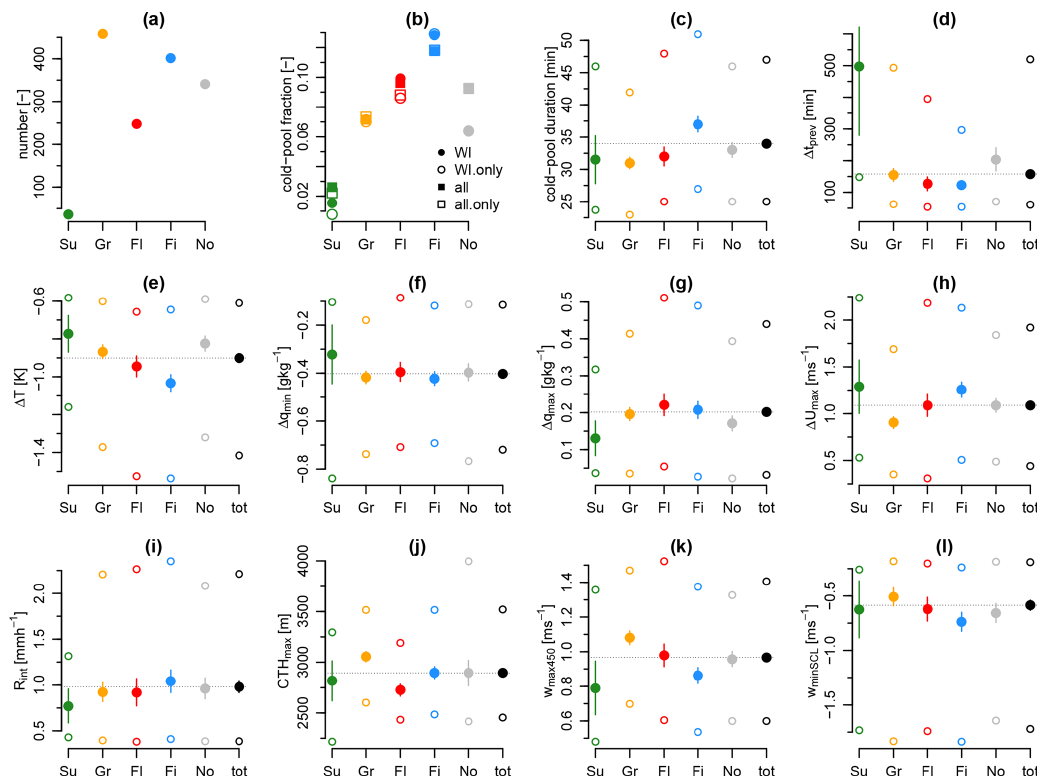
Figure 7. Distributions of various cold-pool diagnostics conditioned on the organization patterns. (a) Number of cold pools, (b) cold-pool fraction, (c) cold-pool duration, (d) time since t min of the last cold pool, (e) (cid:49)T , (f) (cid:49)q min , (g) (cid:49)q max , (h) (cid:49)U max , (i) MRR R int , (j) CTH max , (k) w max450 , and (l) w minSCL . The different symbols in panels (c) – (l) represent the 25%, 50%, and 75% quartiles of the respective variables, the solid lines represent the median ± 1SE, and the dotted horizontal reference lines show the median of the entire set (“tot”). Besides the cold pools matching the noprevWI criterion, panel (b) also shows the fraction of cold pools for all seasons (“all”) and excluding periods with multiple organization patterns (“WI.only” and